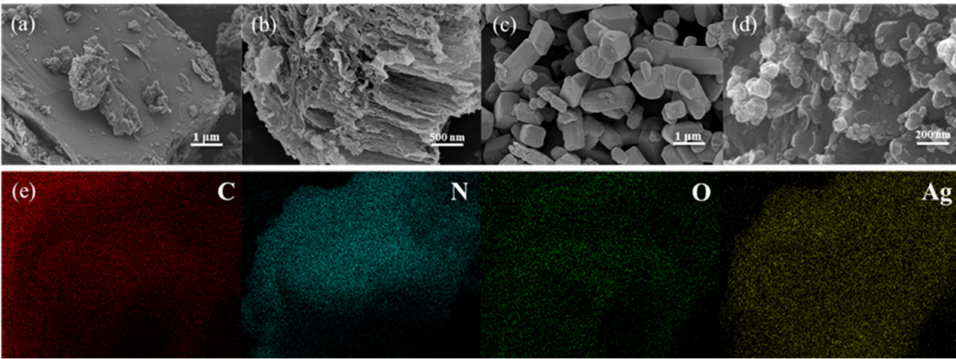
Figure 2. SEM images of ( a ) g-C 3 N 5 , ( b ) n-C 3 N 5 , ( c ) Ag 2 CO 3 , and ( d ) CNAC-10; ( e ) EDX mappings of C, N, O, and Ag elements for